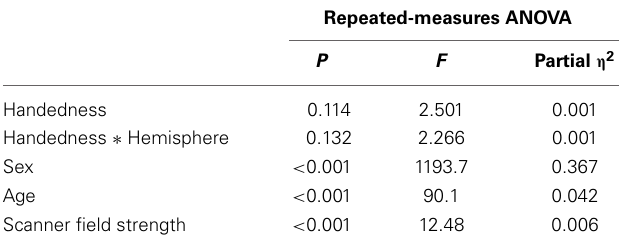
Table 2 | Repeated-measures ANOVA results from testing for an association between handedness and total hemispheric cortical surface